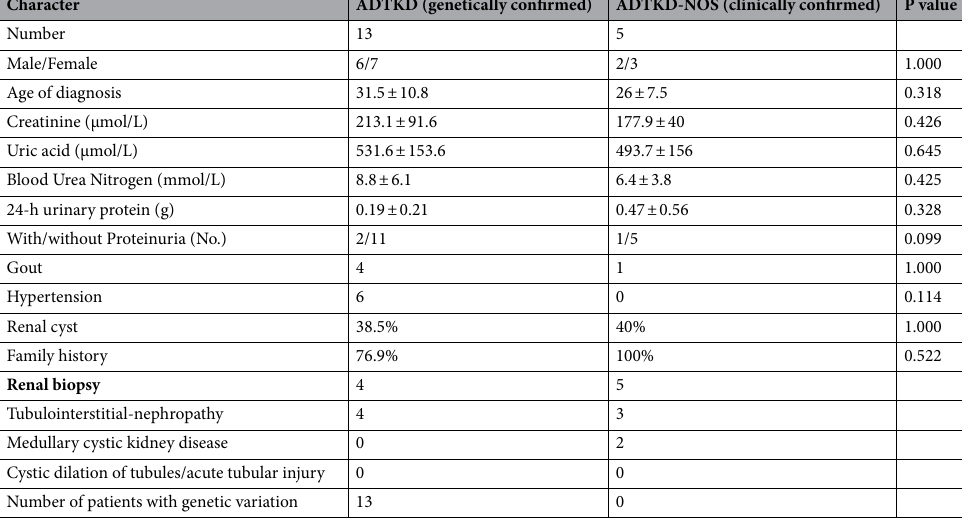
Table 4. Clinical features of the patients with ADTKD and ADTKD-NOS. Statistic analyzed by independent- sample t test or Fisher exact test. Y yes, N no, ADTKD autosomal dominant tubulointerstitial kidney disease, NOS not otherwise specified.